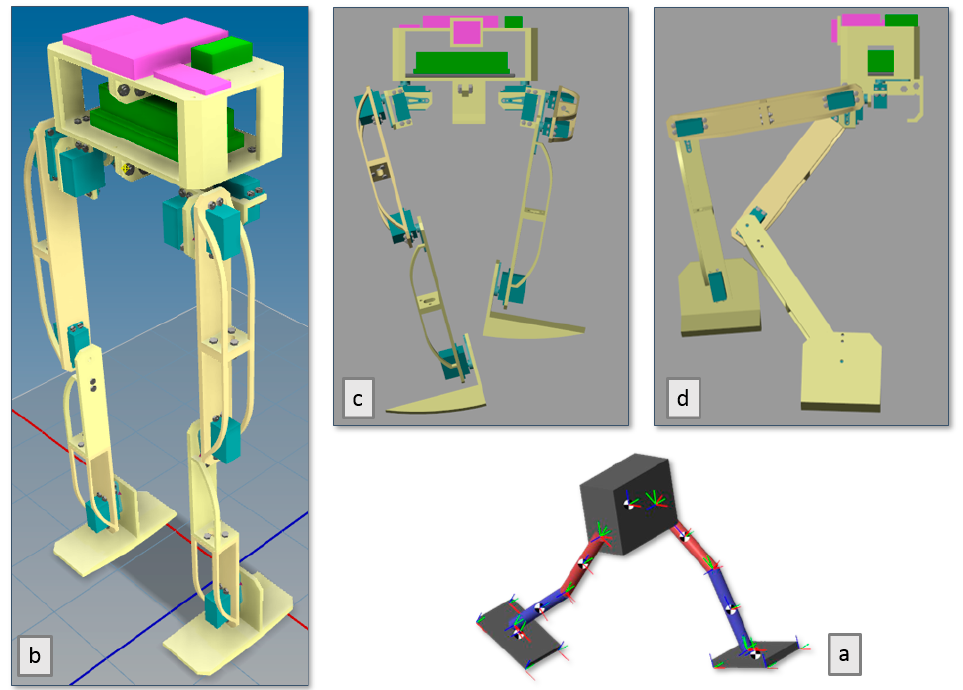
Figure 12. Simulation of walking of the bipedal robot ( a ) basic kinematic model; ( b ) static 3D model; ( c ) walking 3D model—front view; ( d ) walking 3D model—side view.